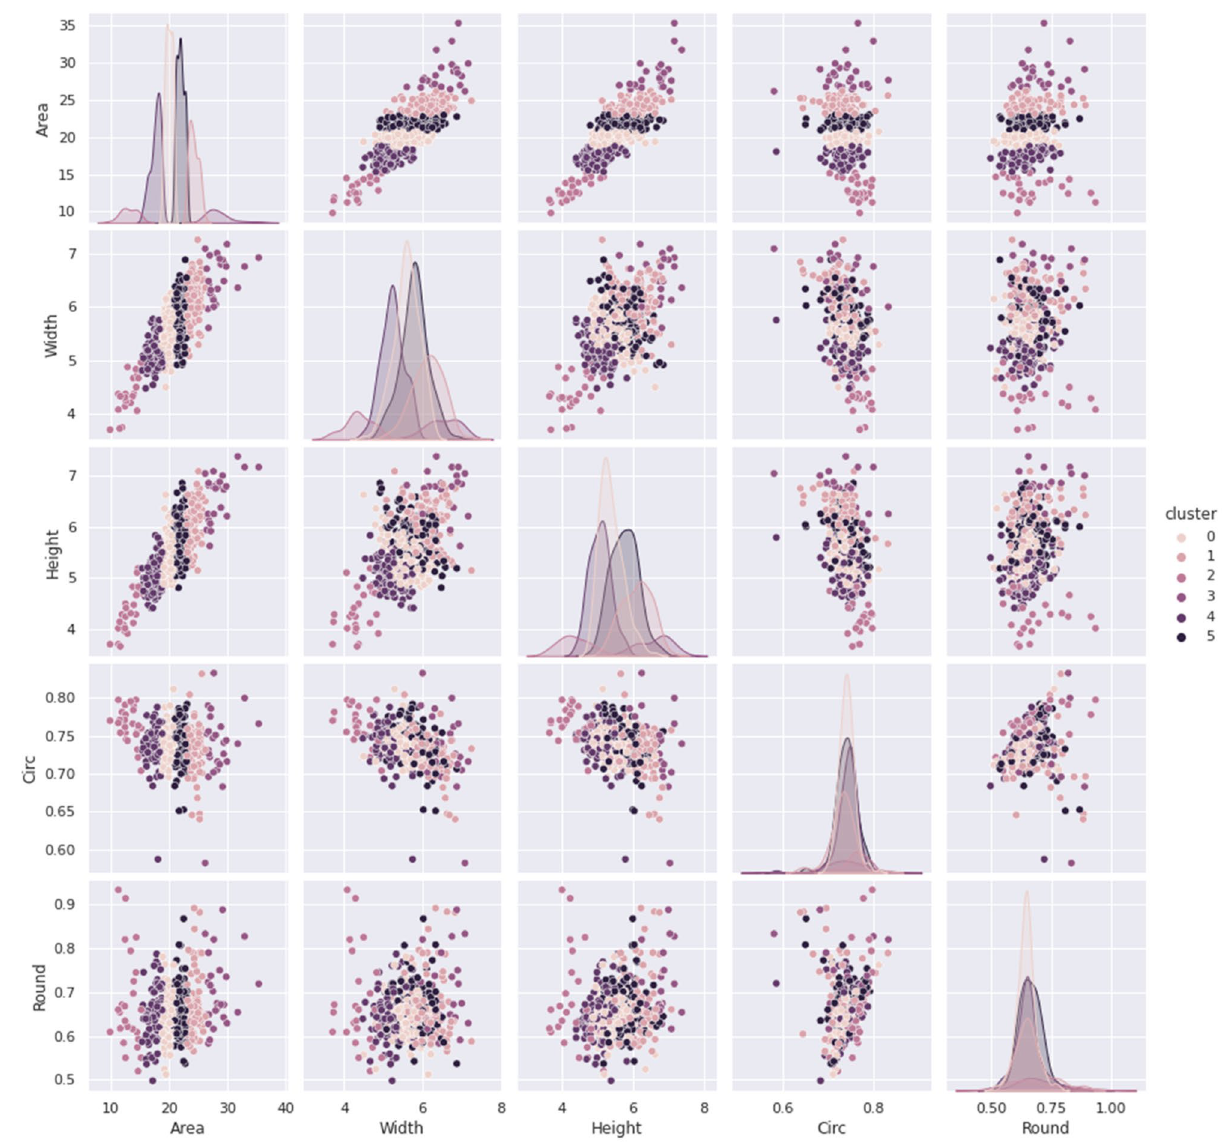
Figure 2. The pair plot of two feature combinations with 6 cluster